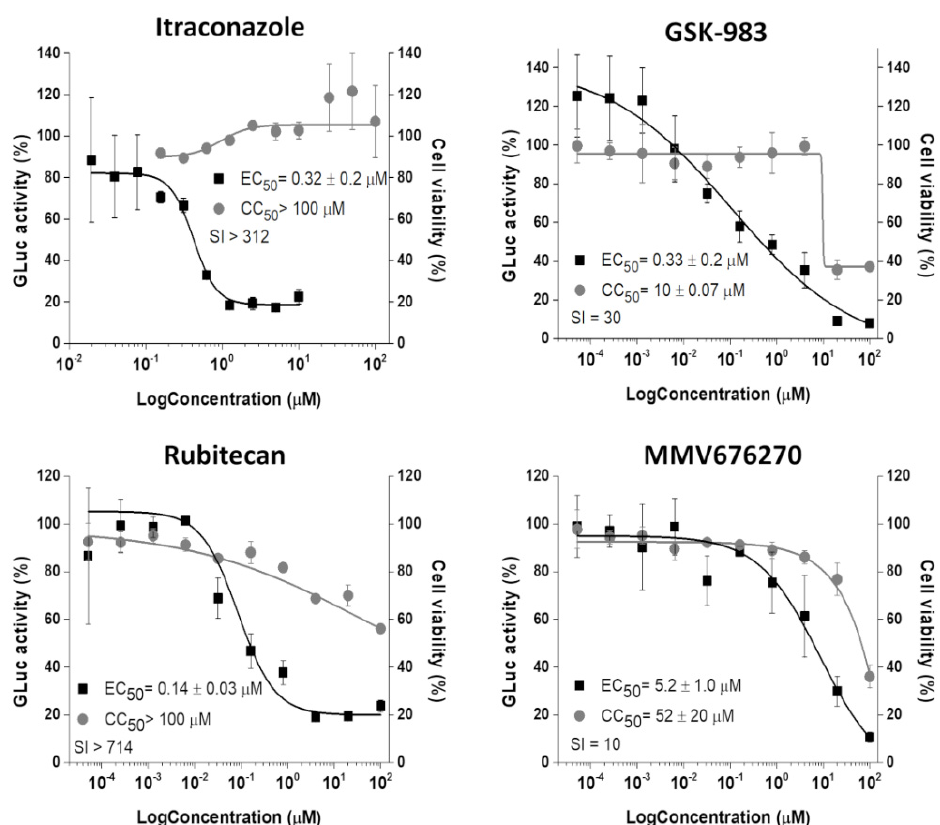
Figure 3. Concentration–response curves (EC 50 and CC 50 ) of selected compounds. The CHIKV replicon cells were treated with compounds at 2-fold (Itraconazole) or 5-fold (GSK-983, rubitecan, and MMV676270) serial dilutions for 48 h. GLuc signal (black squares) was measured from the supernatant, while cell viability (gray circles) was measured employing MTT assay. Average results of two independent experiments. Error bars represent standard deviations.